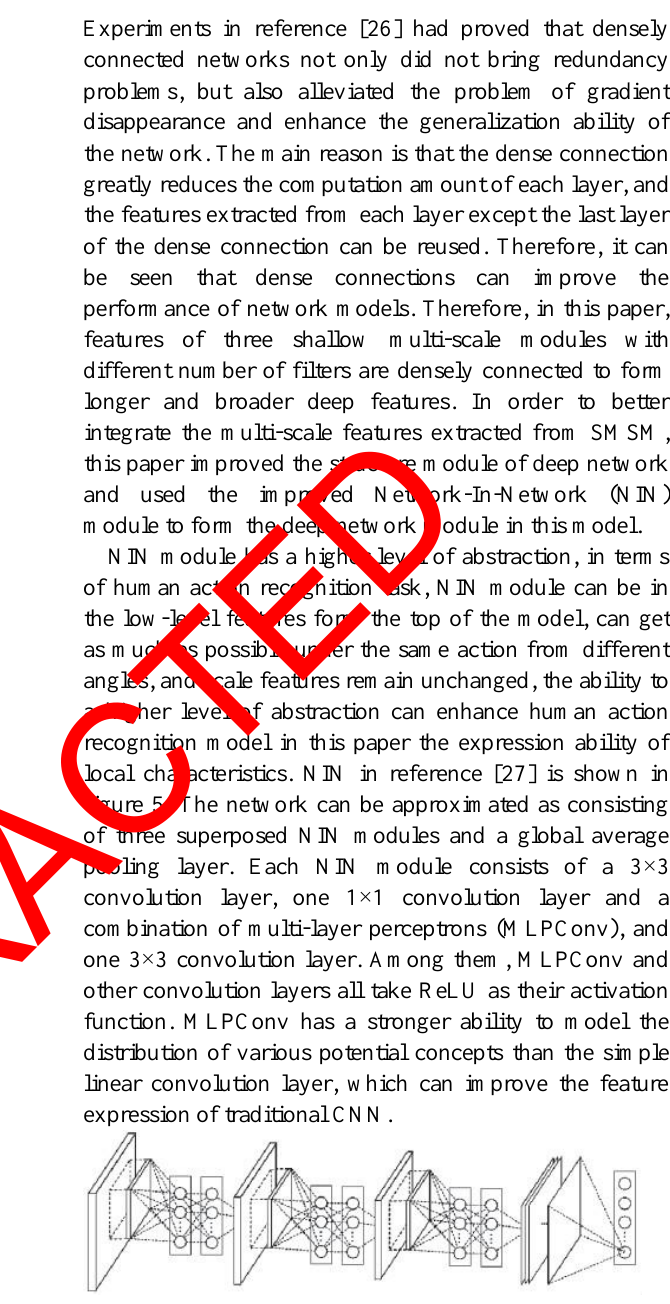
Figure 5. Overall structure of